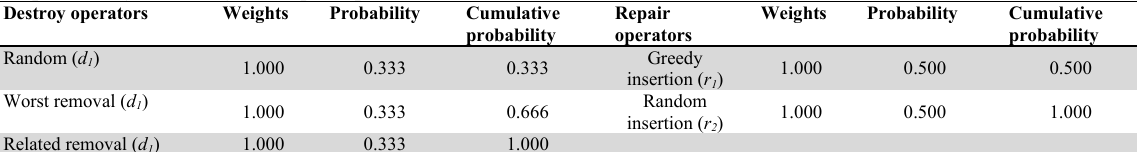
The probability of destroy and repair